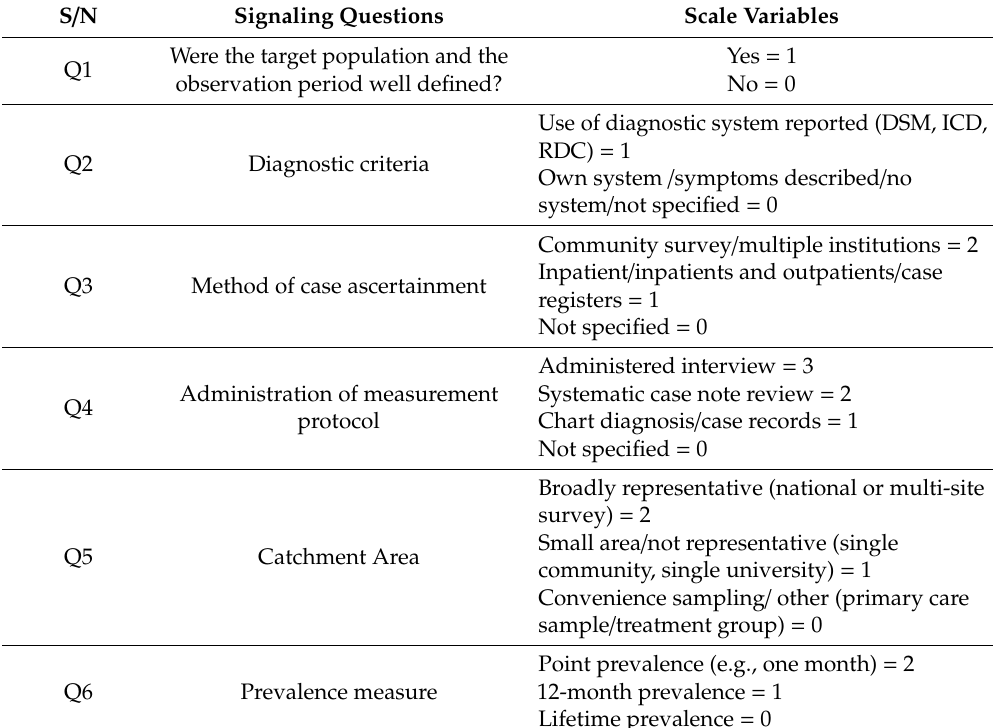
Table A1. Health states Quality Scale Variables adopted from